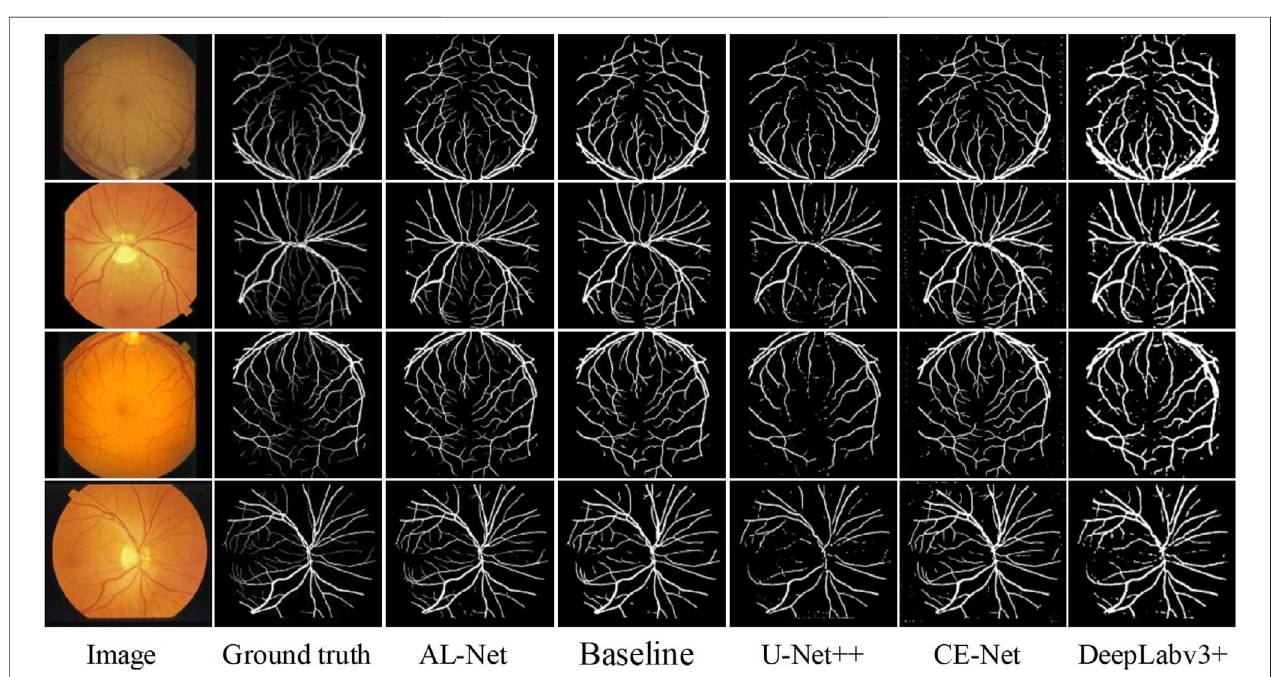
FIGURE 5 | The segmentation results of fi ve models for retinal vessels images.